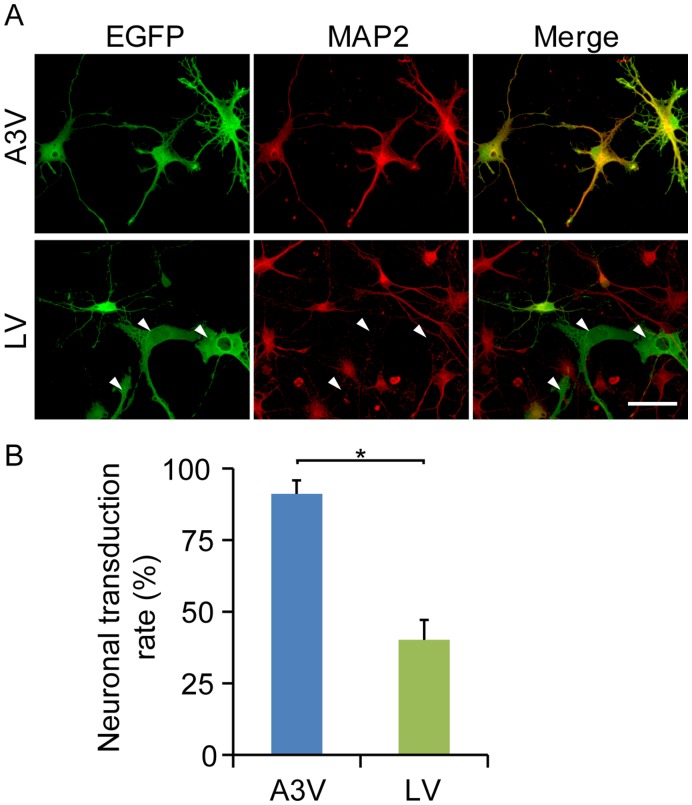
Neuron-preferential transduction of A3V vector.(A) Primary cultures of chick neural cells after A3V or LV infection were immuno-labeled with antibodies against EGFP (green) and the neuronal marker MAP2 (red). Arrowheads indicate MAP2-negative, LV-transduced cells. Scale bar indicates 20 µm. (B) The neuronal transduction rates of A3V and LV are represented as the percentage of MAP2 and EGFP double-positive cells within 100–200 EGFP-positive cells (n = 4). *p<0.005. The raw data are listed in Table S3.